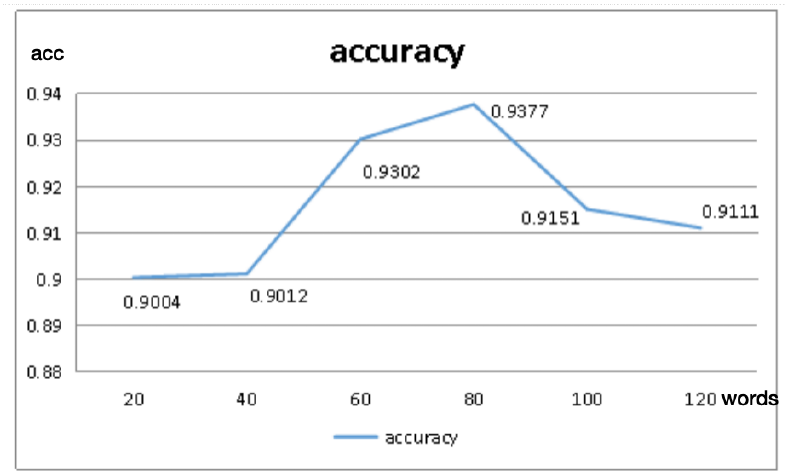
Figure 4. Accuracy vs. article